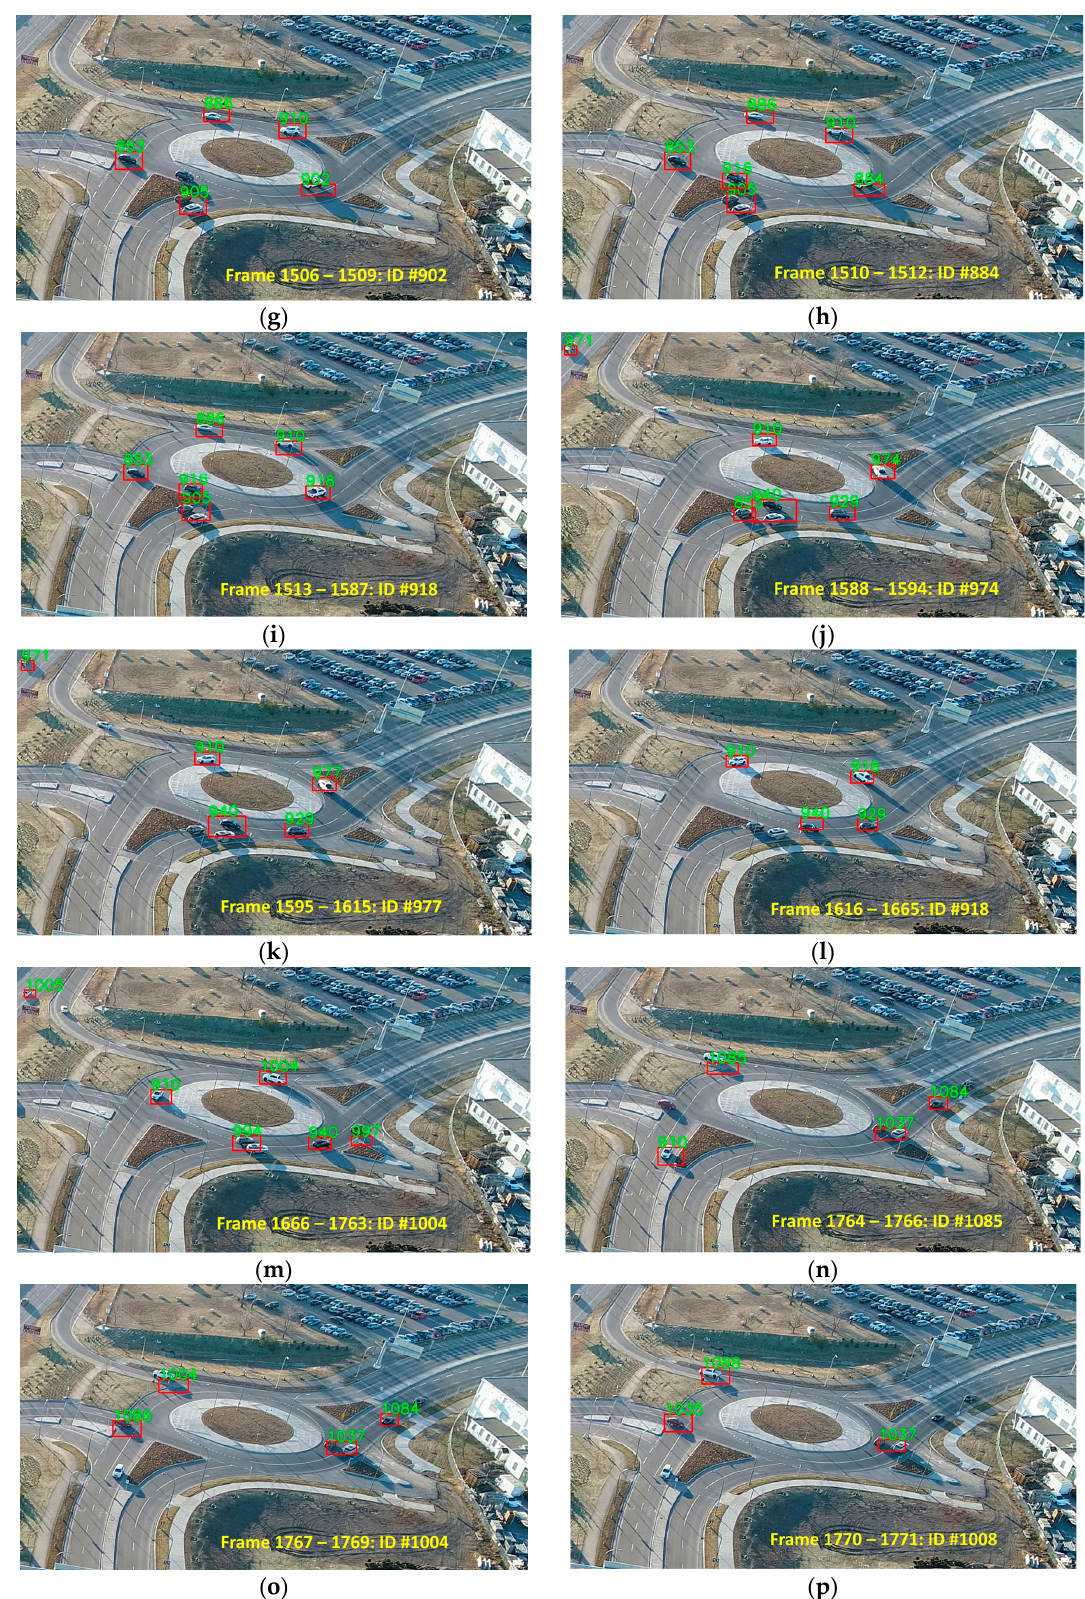
Figure 9. The identity of the vehicles could be recovered every now and then. The identity of the same vehicle changes as: ( a ) 786; ( b ) 884; ( c ) 902; ( d ) 909; ( e ) 912; ( f ) 914; ( g ) 902; ( h ) 884; ( i ) 918; ( j ) 974; ( k ) 977; ( l ) 918; ( m ) 1004; ( n ) 1085; ( o ) 1004; ( p ) 1008. This example is selected from DJI video 2.